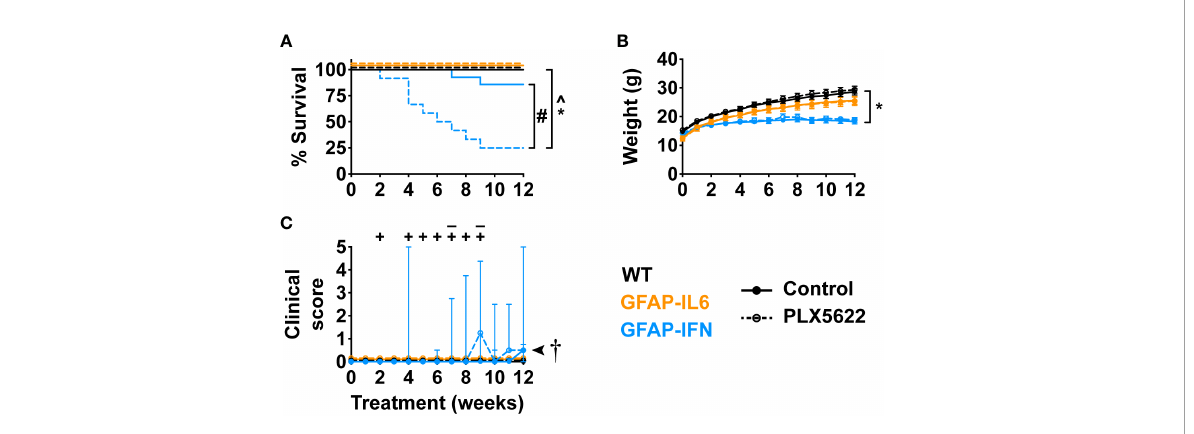
FIGURE 3 PLX5622 treatment increases the susceptibility of GFAP-IFN mice to seizures and death. (A) Survival, (B) weight and (C) clinical score of 1- month-old mice treated with control or PLX5622 diet for 12 weeks. Solid lines represent control diet-fed mice and dashed lines represent PLX5622 diet-fed mice. In (C) , the ‘–’ symbols indicate when untreated GFAP-IFN mice died and ‘ + ’ symbols indicate when PLX5622-treated GFAP-IFN animals died. n=12-24 mice/group. For (B) , graph shows mean ± SEM, for (C) , graph shows median + interquartile range. Signi fi cance of survival between genotypes and treatment groups was calculated by the log-rank test with Benjamini-Hochberg post-test. Signi fi cance of weight between genotypes and treatment groups was calculated with linear mixed-effects models and p-values adjusted with Tukey ’ s post-test. Signi fi cance of clinical scores between untreated and PLX5622-treated GFAP-IFN mice was calculated with cumulative link mixed models with p-values adjusted using the Bonferroni method. *p<0.05 compared with WT of same diet; ^p<0.05 compared with GFAP-IL6 of same diet; # p<0.05 compared with untreated control of same genotype; † , the signi fi cance of the clinical scores of PLX5622-treated GFAP-IFN mice compared with untreated GFAP-IFN mice was